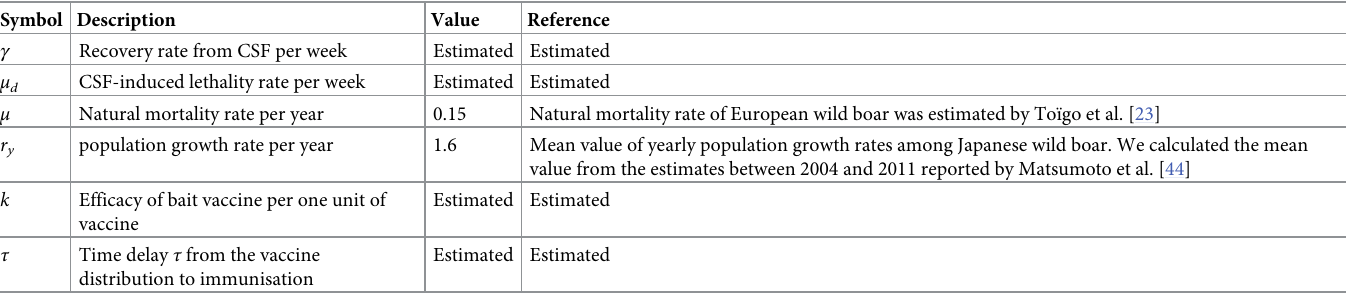
Table 1. Descriptions of parameters for the